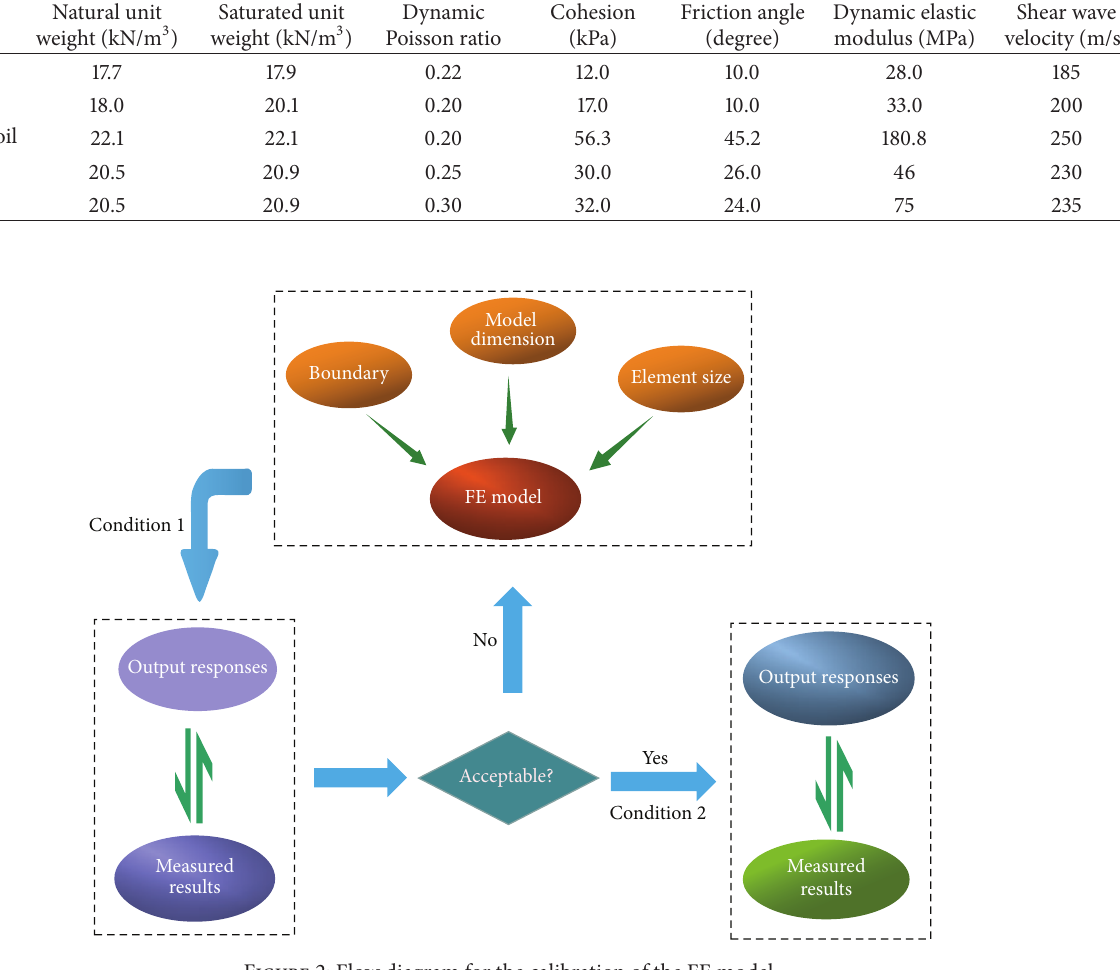
Figure 2: Flow diagram for the calibration of the FE